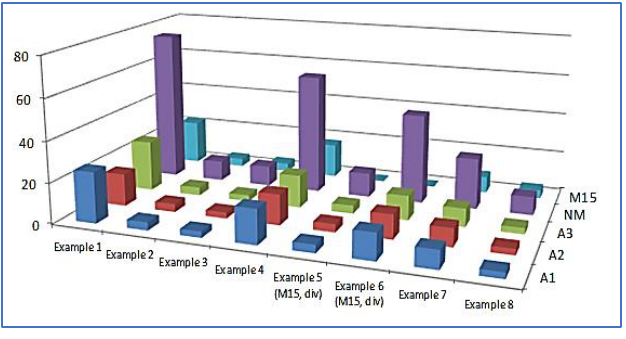
Fig. 2. Comparison of number of iterations to achieve specified error tolerance in all methods for examples 1-8